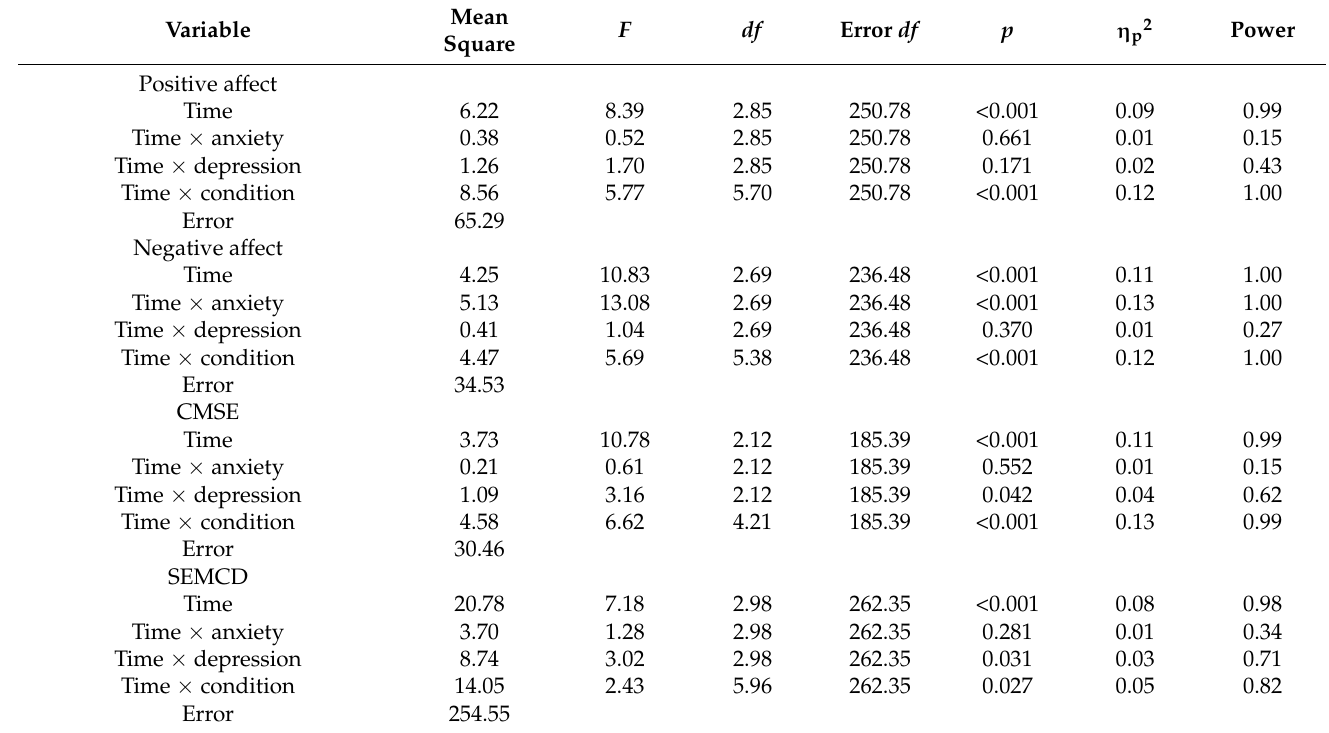
Table 2. Within-subject effects of the